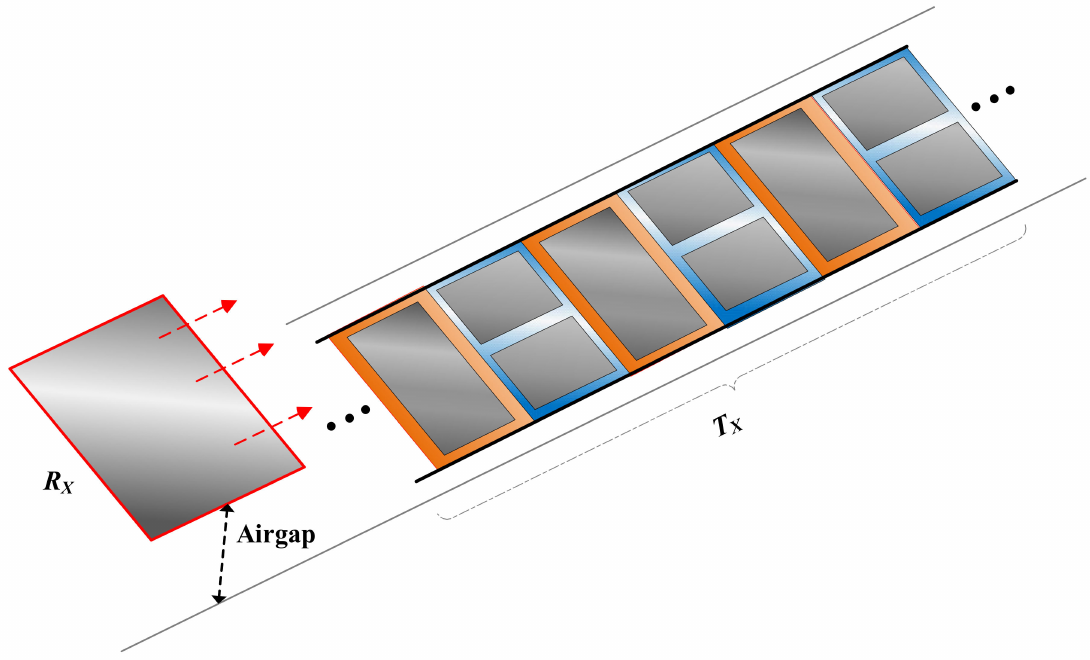
Figure 2. The overview diagram of the whole